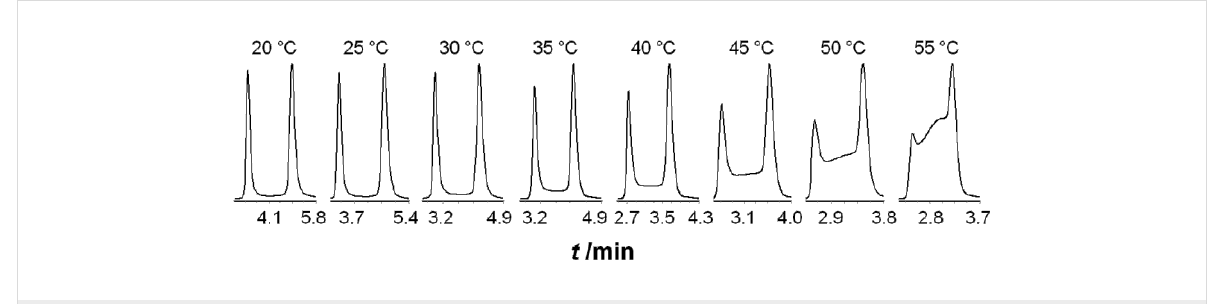
Figure 3: Elution profiles obtained by temperature-dependent DHPLC measurements of 4 .